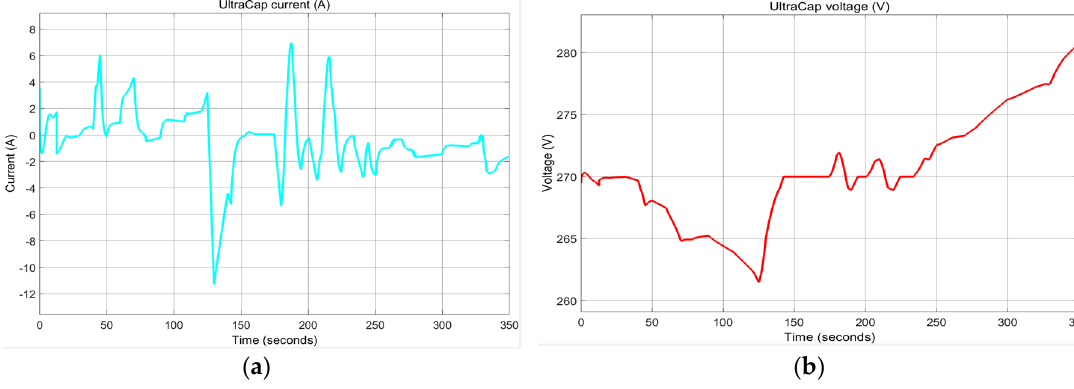
Figure A6. SC specific variables. ( a ) SC current variation; ( b ) SC voltage.